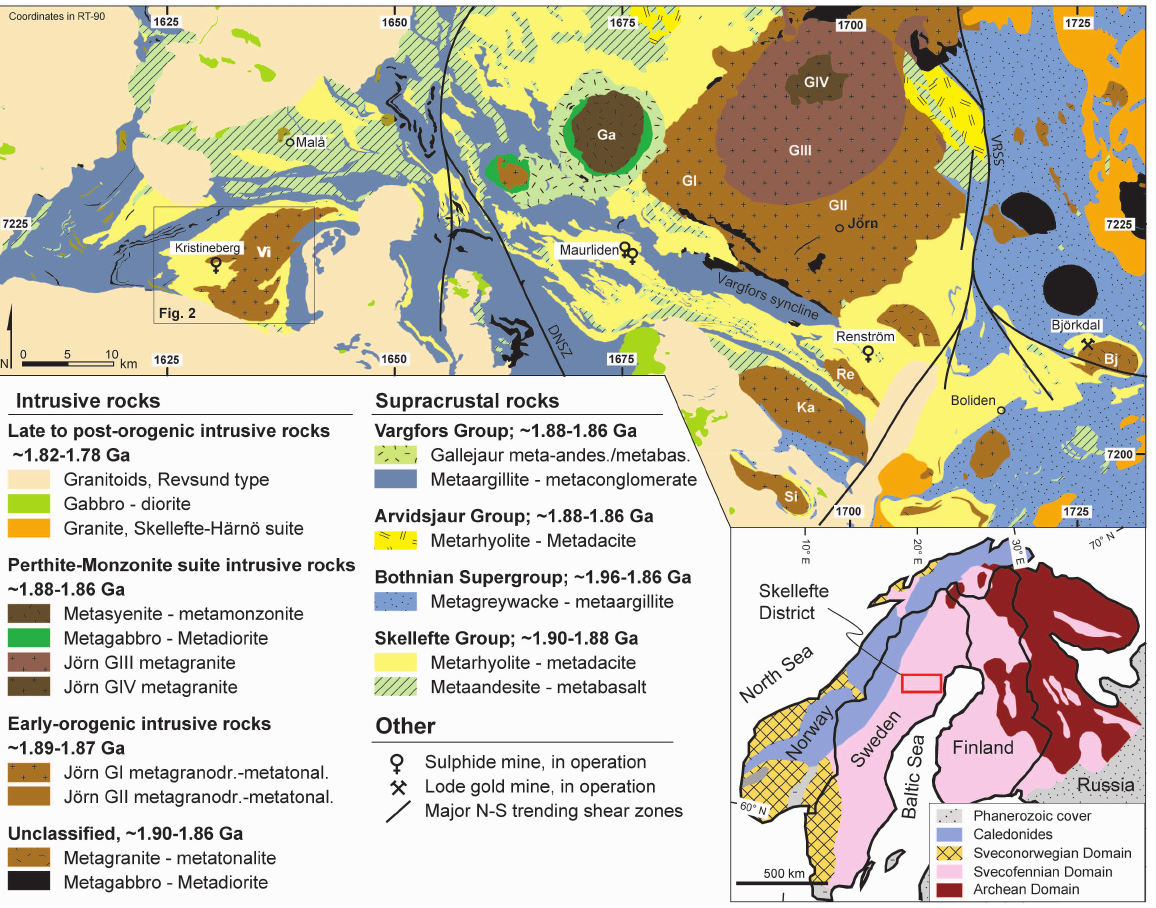
Fig. 1. Inset: geological overview of the Fennoscandian Shield. SD=Skellefte District. Main map: DNSZ=Deppis-N¨asliden shear zone; VRSS=Vidsel-R¨ojn¨oret shear system; Intrusions: Vi=Viterliden; Re=Reng˚ard, Ka=Karstr¨ask, Si=Siktr¨ask, Bj=Bj¨orkliden, Ga=Gallejaur, GI, GII, GIII, GIV=J¨orn type intrusions phases I–IV. Geology modified after Kathol and Weihed (2005) and Bergman Weihed